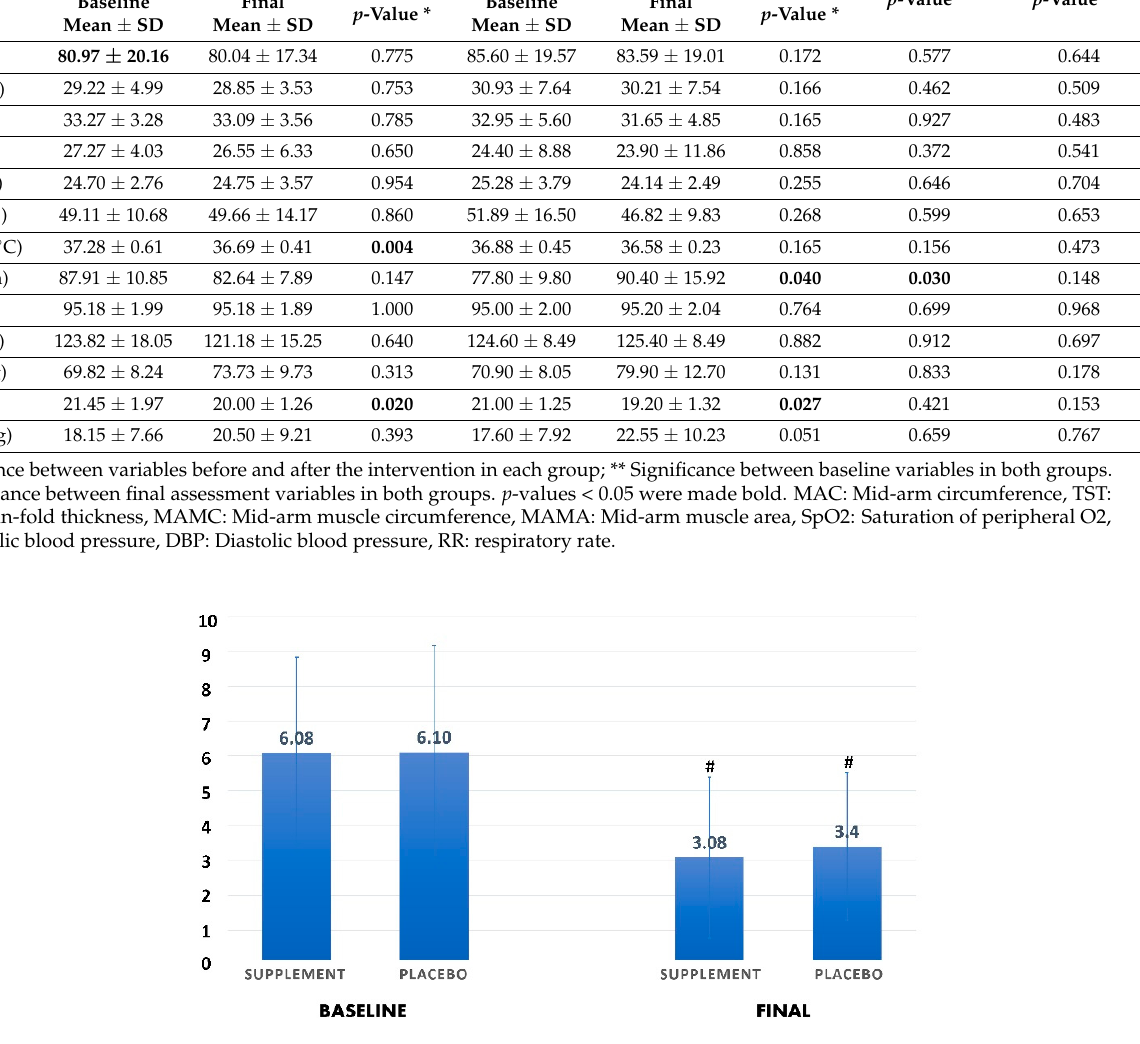
Table 2. Anthropometric and clinical parameters before and after intervention in both study groups.